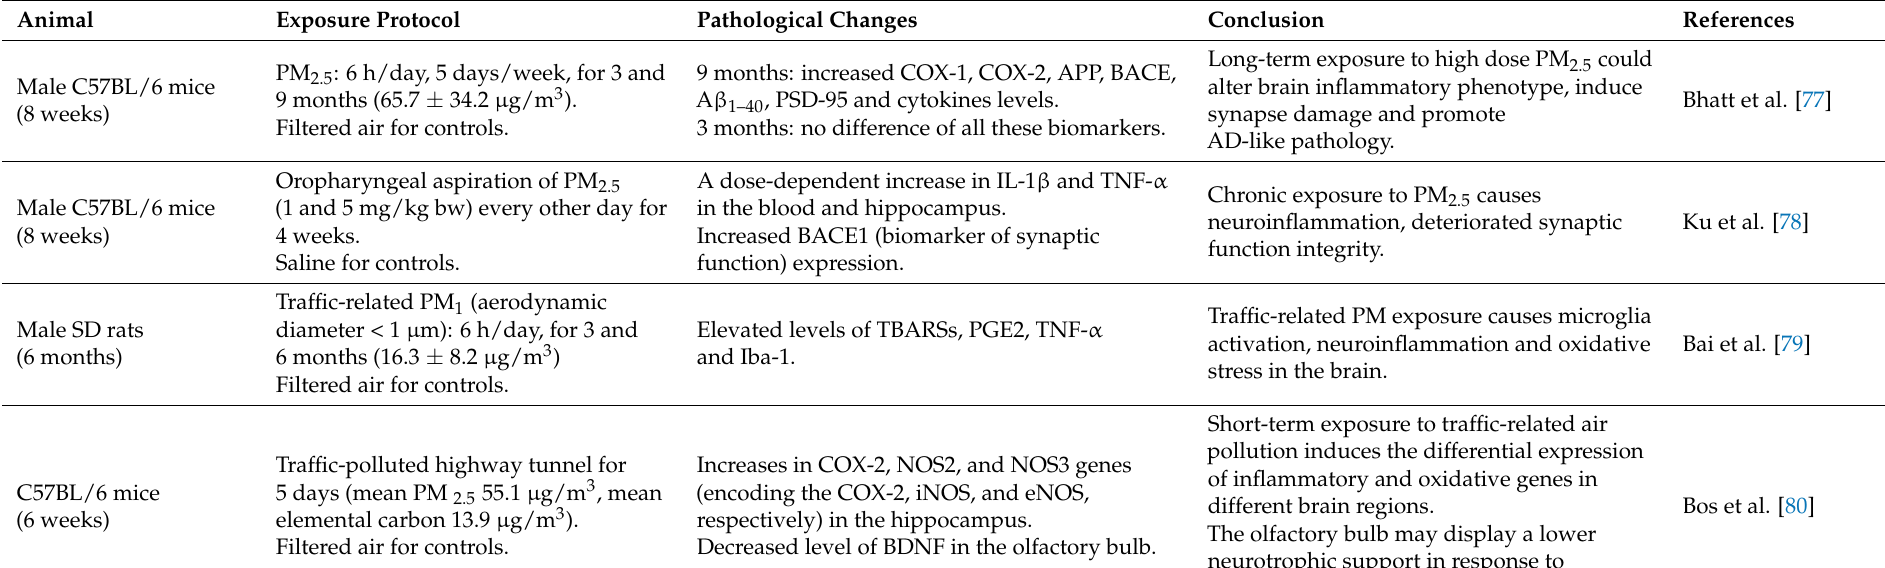
Table 2. Evidence from main animal studies with PM 2.5